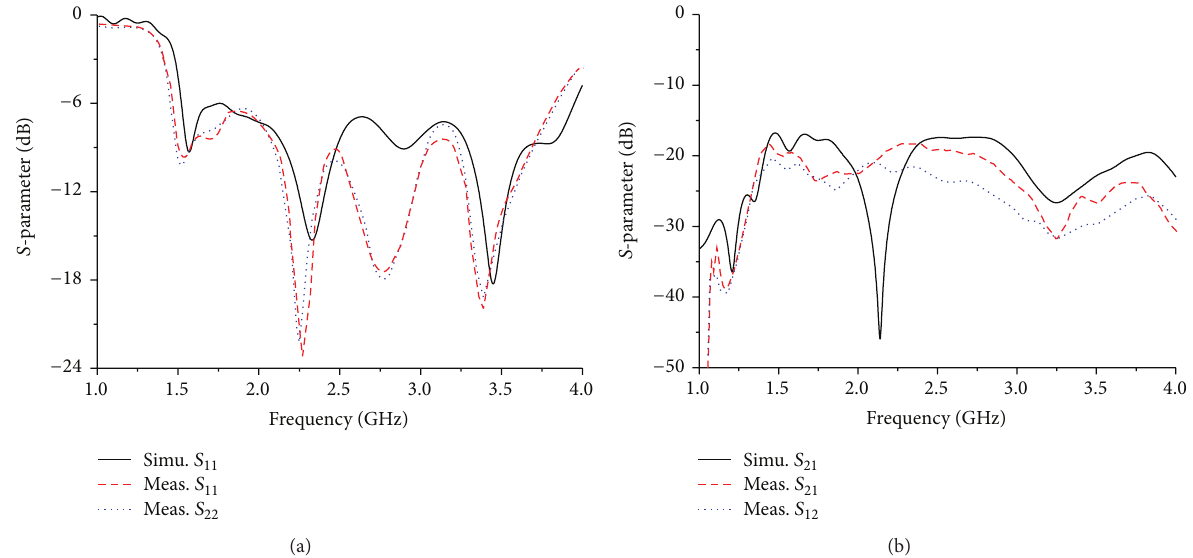
Figure 6: Simulated and measured 𝑆 parameters of the proposed antenna: (a) 𝑆 11 ; (b) 𝑆 21